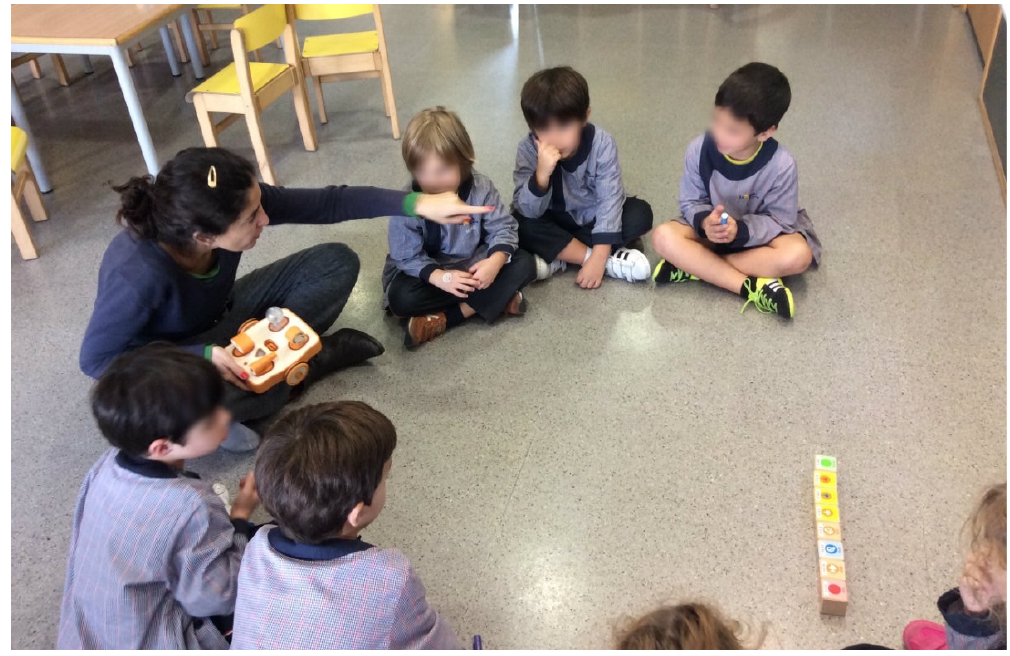
Figure 1. Teaching students with the KIBO